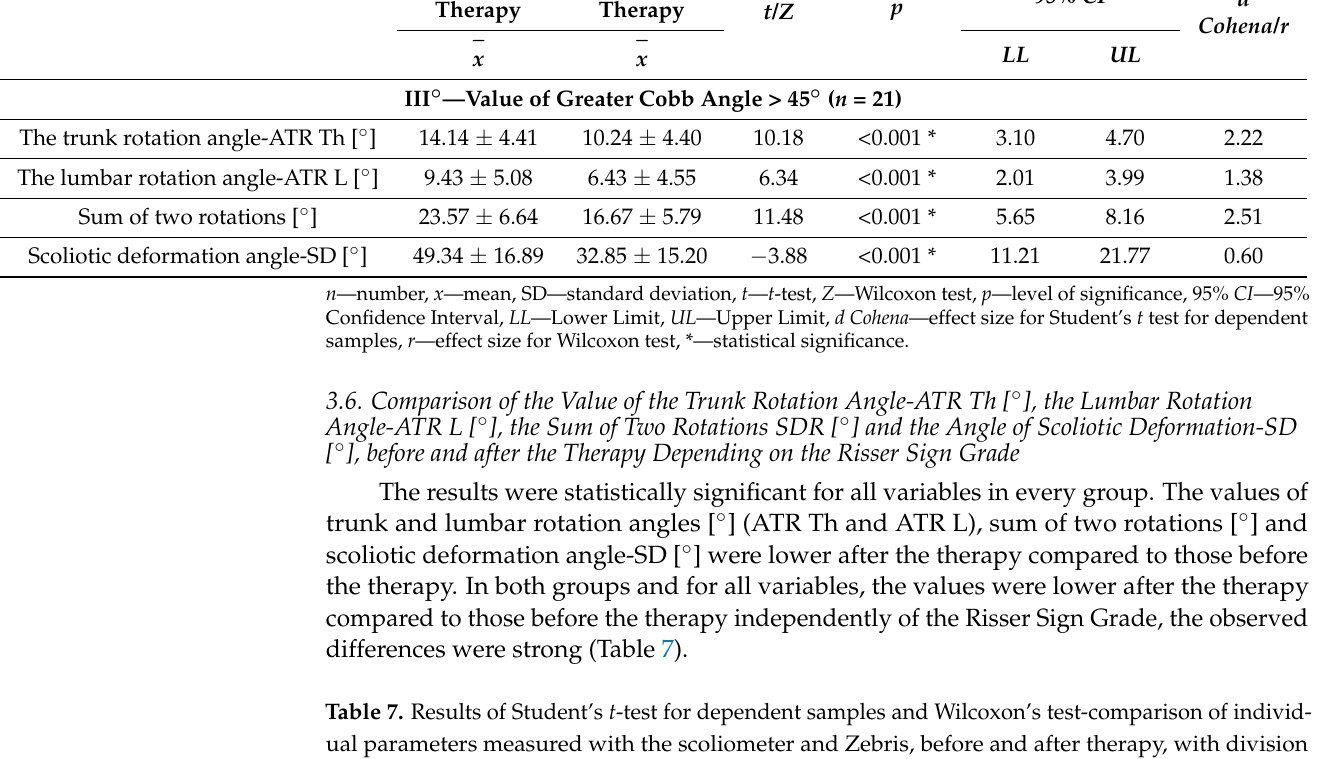
Table 7. Results of Student’s t -test for dependent samples and Wilcoxon’s test-comparison of individ- ual parameters measured with the scoliometer and Zebris, before and after therapy, with